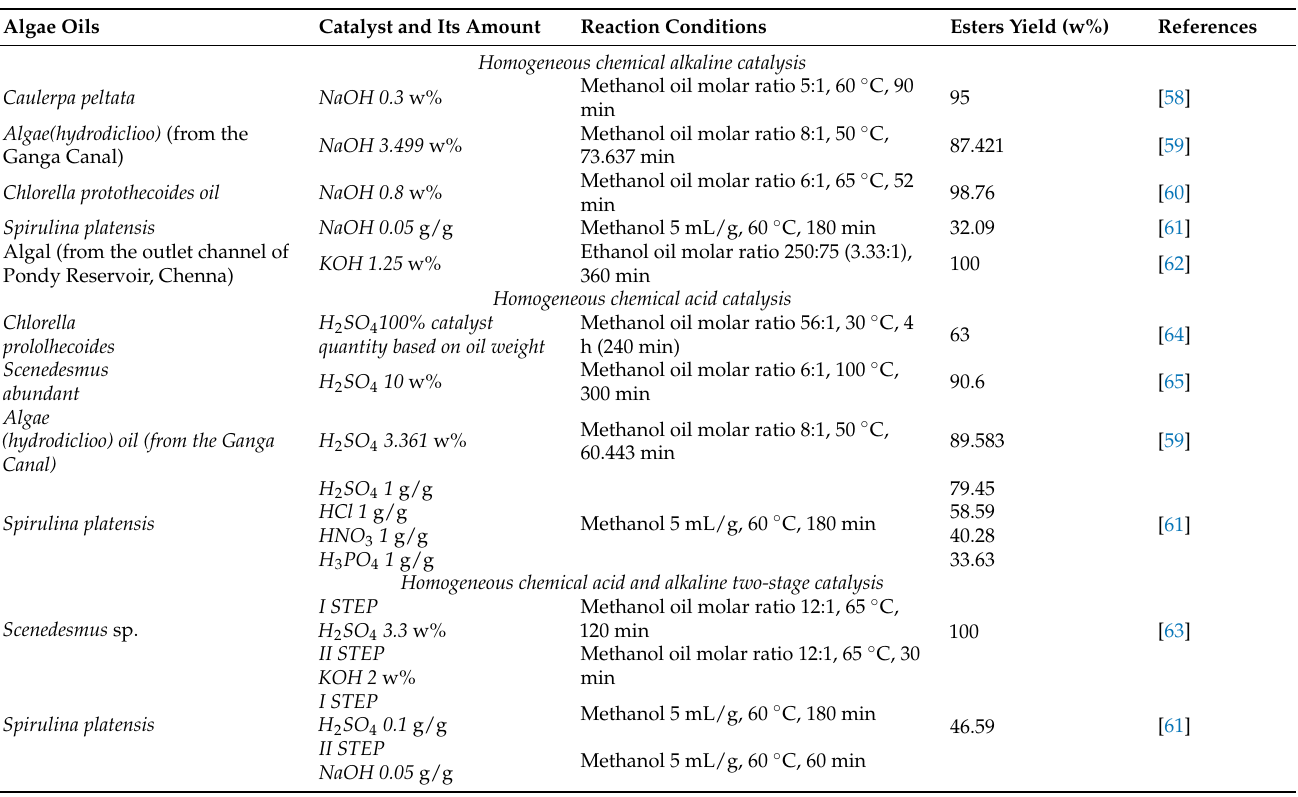
Table 5. Effectiveness of homogeneous catalyst application for transesterification of microalgae oil.